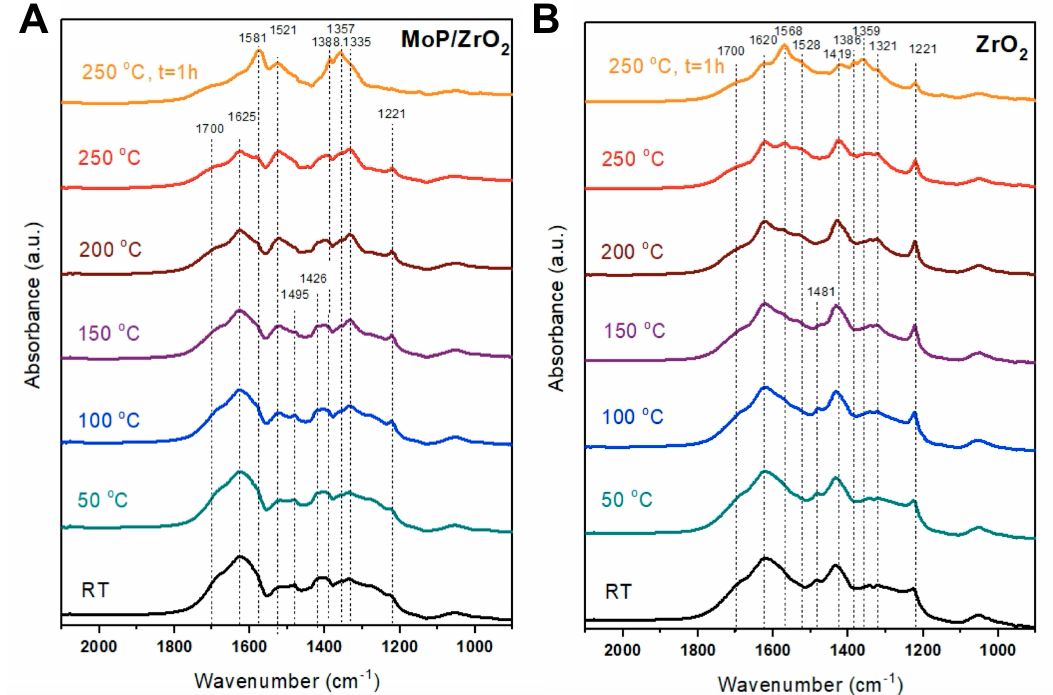
Figure 6. Diffuse Reflectance Infrared Fourier Transform Spectroscopy-Temperature Programmed Surface Reaction (DRIFTS-TPSR) of MoP/ZrO 2 ( A ) and ZrO 2 ( B ) at 8.8 bar to 250 o C. Both tests performed after reduction at 450 °C in hydrogen.